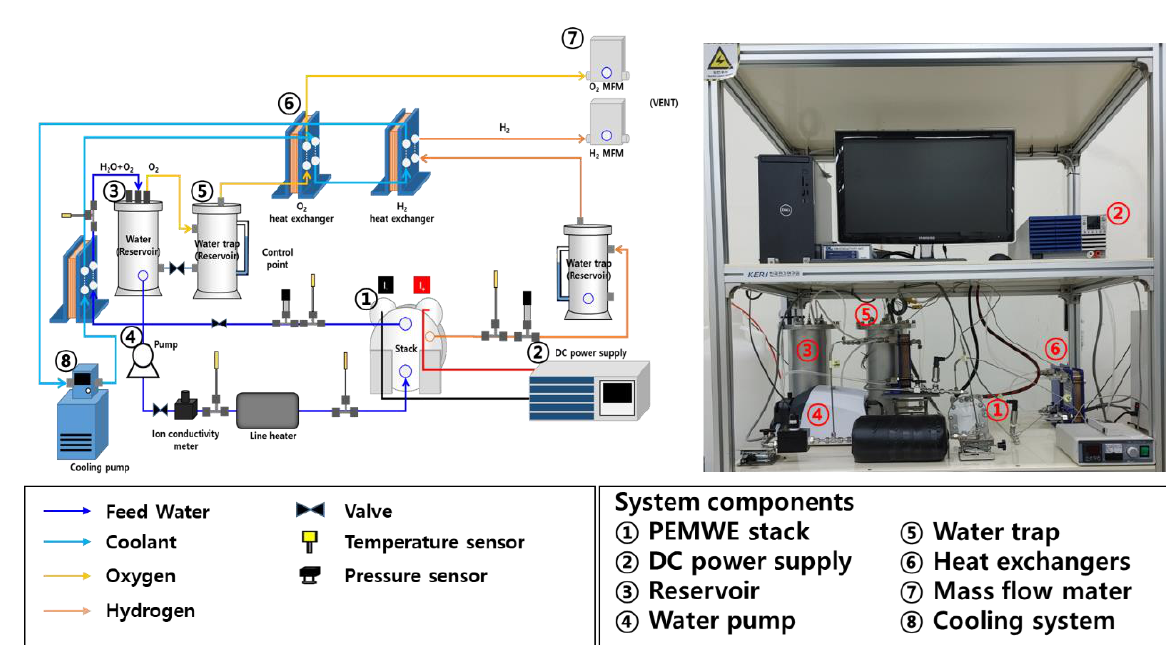
Figure 2. Schematic diagram and experimental device of 300 W PEMWE system .